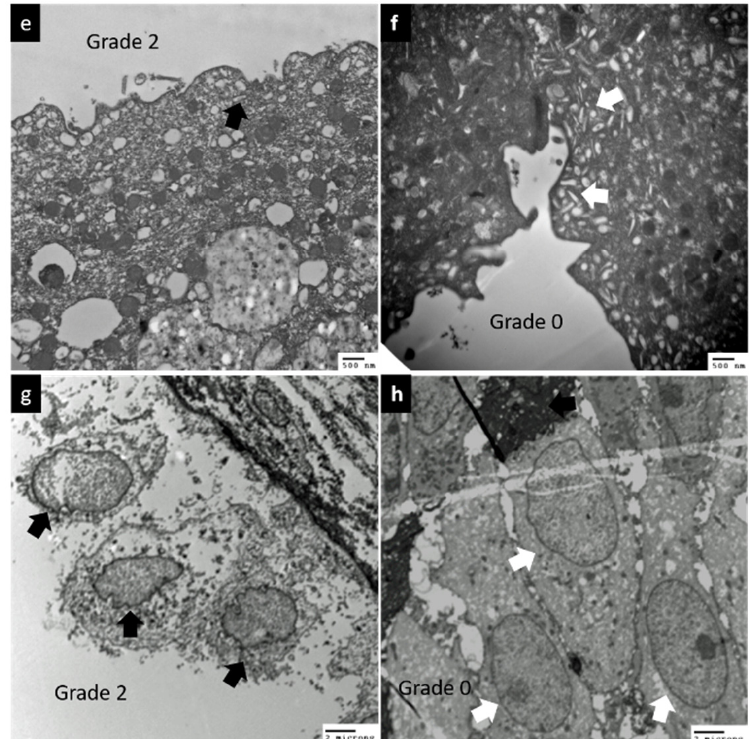
Figure 1. Comparison of the changes in urothelial ultrastructural defects before and after platelet-rich plasma (PRP) injections (samples from the same patient). ( a ) Before PRP: A sample with a grade 3 severe urothelial cell layer defect with only 1 urothelial cell layer (black double-headed arrow). ( b ) After PRP: A sample with grade 0 and 3–6 urothelial cell layers (white double-headed arrow). ( c ) Before PRP: A sample with grade 3 tight junction defects between >50% of umbrella cells (black arrows). ( d ) After PRP: A sample with grade 0 intact tight junctions (white arrows). ( e ) Before PRP: A sample with grade 2 decrease in uroplakin plaques (white arrows). ( f ) After PRP: A sample with grade 0 numerous uroplakin plaques (black arrows). ( g ) Before PRP: A sample with grade 2 swollen nuclei (black arrows) and ruptured organelles (black arrows). ( h ) After PRP: A sample with grade 0 normal nuclei and organelles (white arrows).